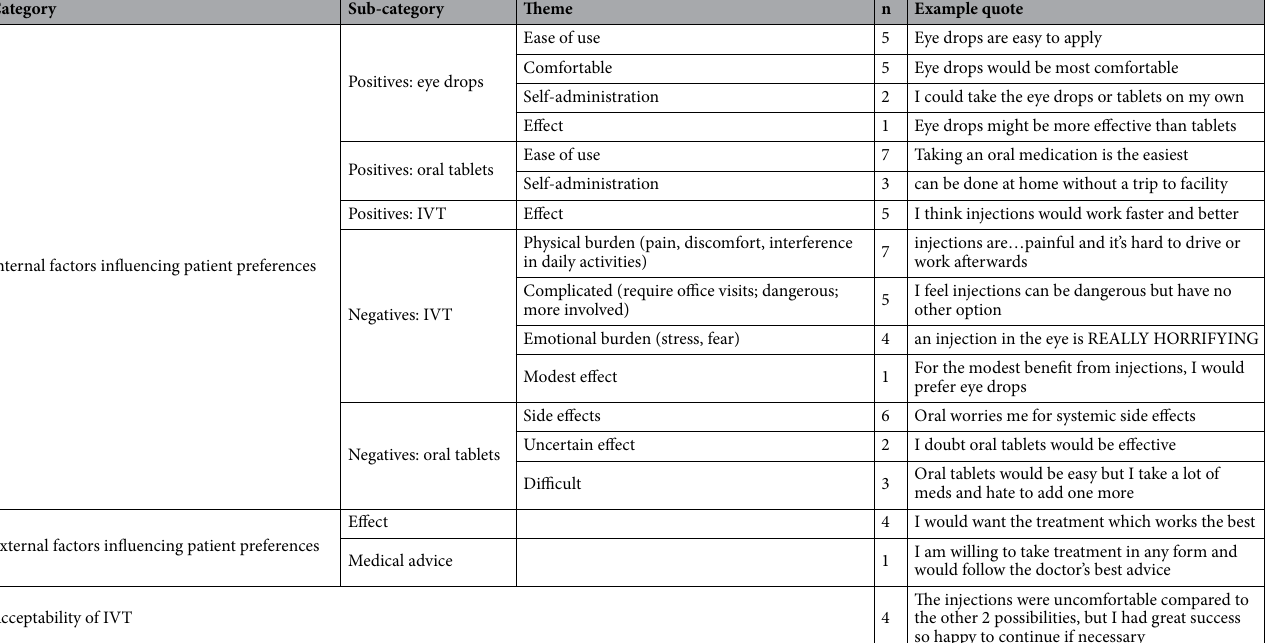
Table 4. Reported reasons for future treatment delivery preferences. Some respondents spoke to more than one theme. n = 48 narrative